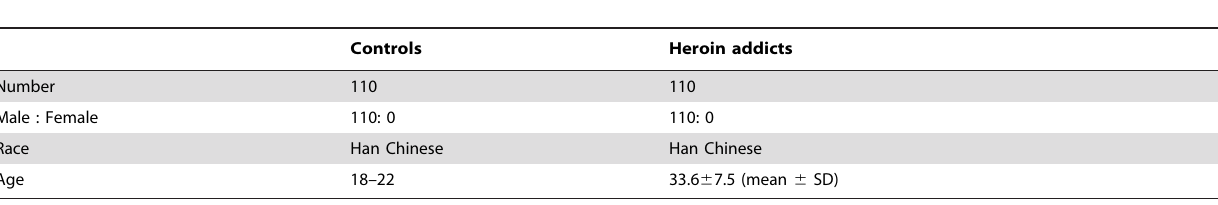
Table 1. Demographic information of